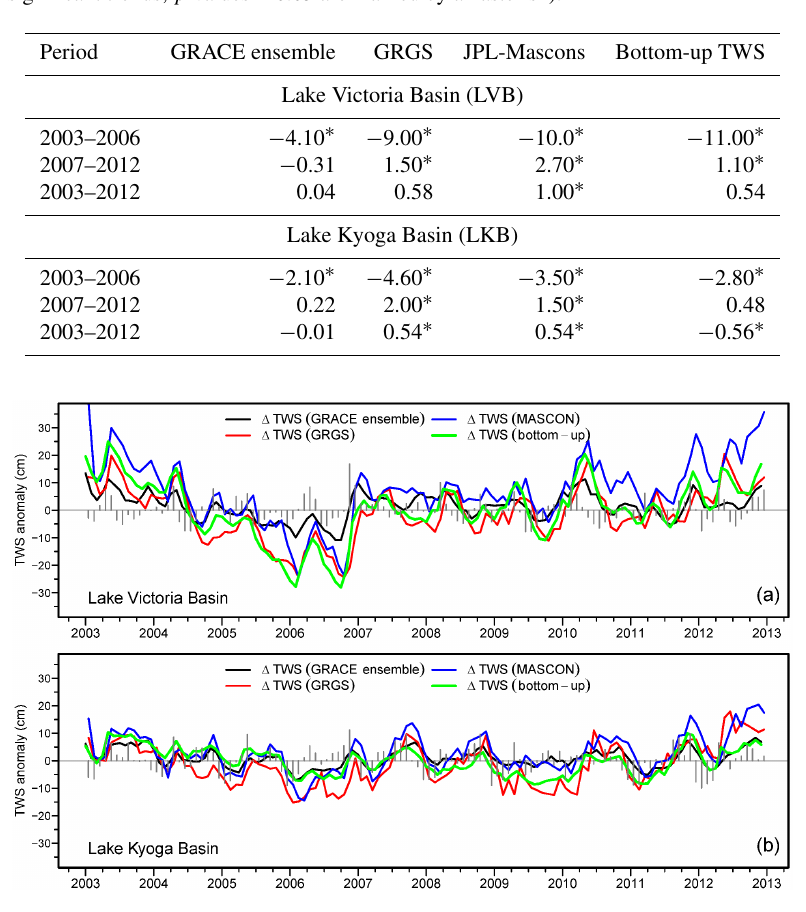
Figure 7. Comparison among time-series records of (cid:49) TWS from GRCTellus (ensemble mean of CSR, GFZ, and JPL), GRGS and JPL- Mascons GRACE products and bottom-up (cid:49) TWS for the LVB (a) , and the LKB (b) for the period of January 2003 to December 2012. The vertical grey lines represent monthly rainfall anomalies in the LVB and